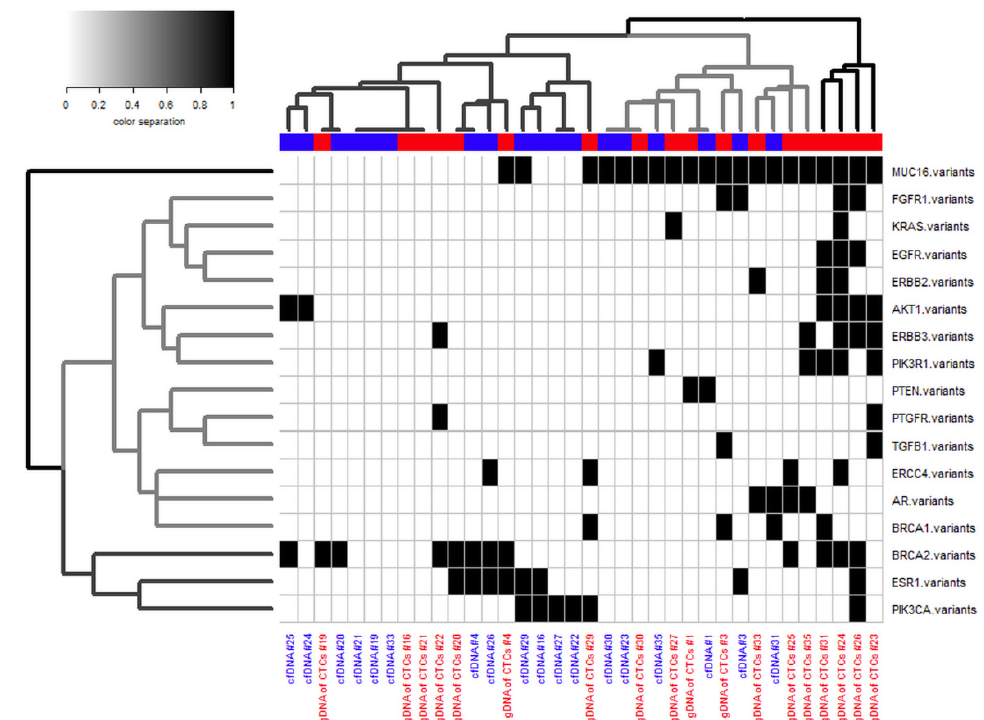
Figure 5. Heatmap plus hierarchical clustering summarizing the similarity of the samples. Samples showing at least one variant within the mentioned gene are marked in black. Hierarchical clustering was conducted according to Ward’s method with Euclidean distance.